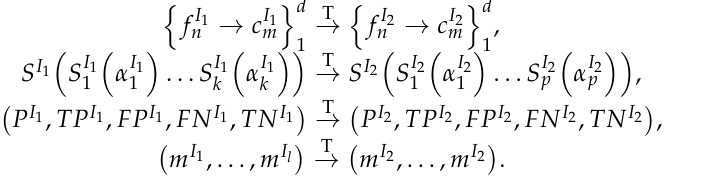
Figure 6. The mapping process of the second R-instance.